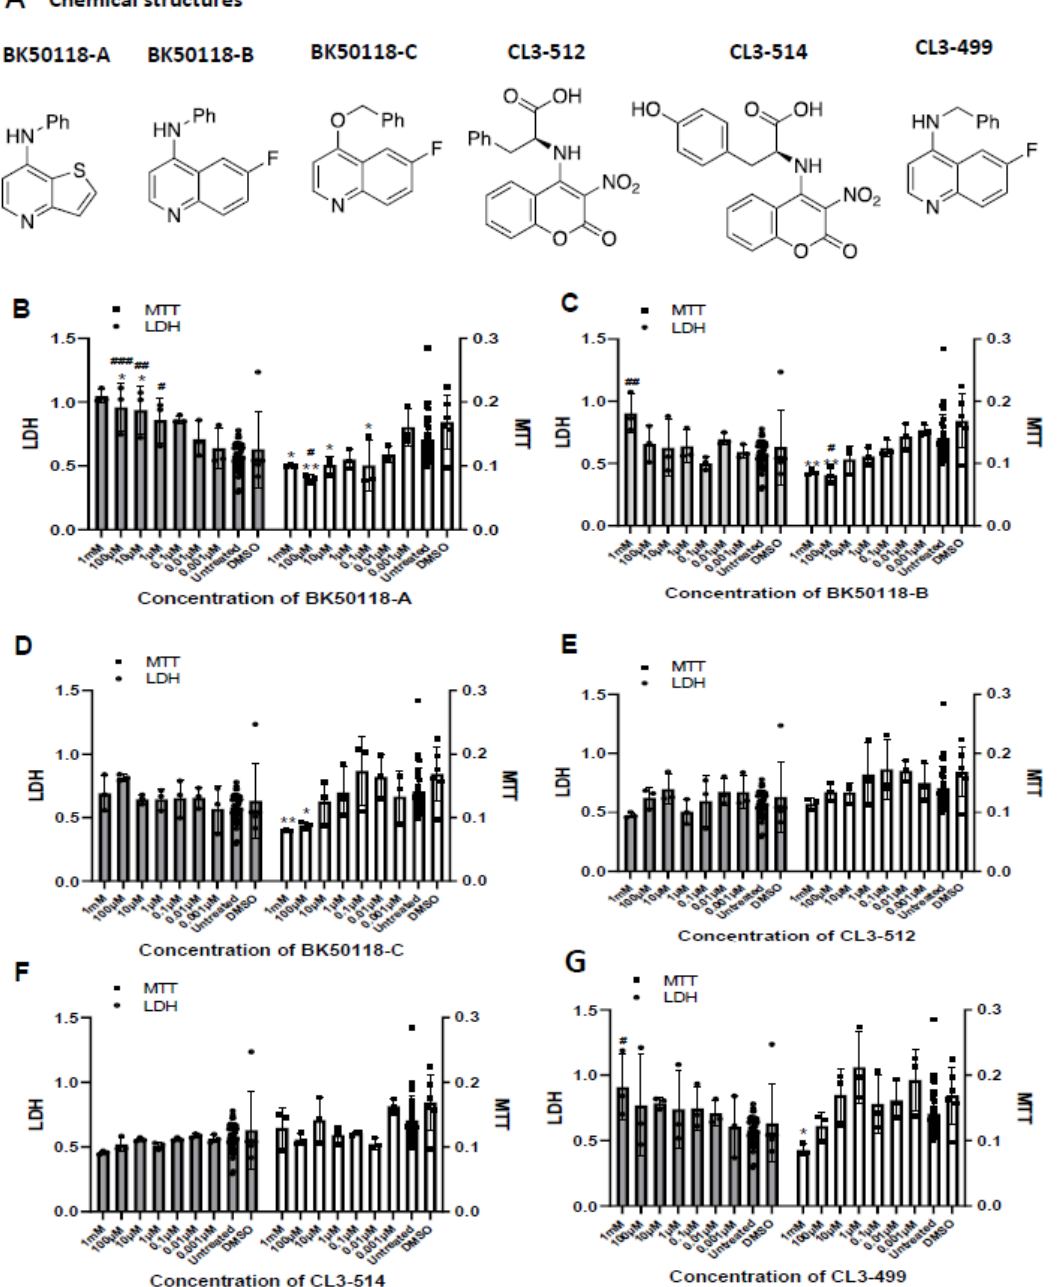
Figure 2. Chemical structures and cell viability assays of the 6 novel small molecule compounds in vitro. ( A ) Chemical structures of BK50118-A, BK50118-B, BK50118-C, CL3-512, CL3-514 and CL3-499. ( B – G ) LDH and MTT Cell viability assays of the 6 small molecule compounds. SH-SY5Y cells were treated with a serial of concentrations of each individual compound for 5 h. * p < 0.05, ** p < 0.01 to DMSO group, # p < 0.05, ## p < 0.01, ### p < 0.001 to untreated group; ordinary one-way ANOVA; N = 3–30 per treatment group.